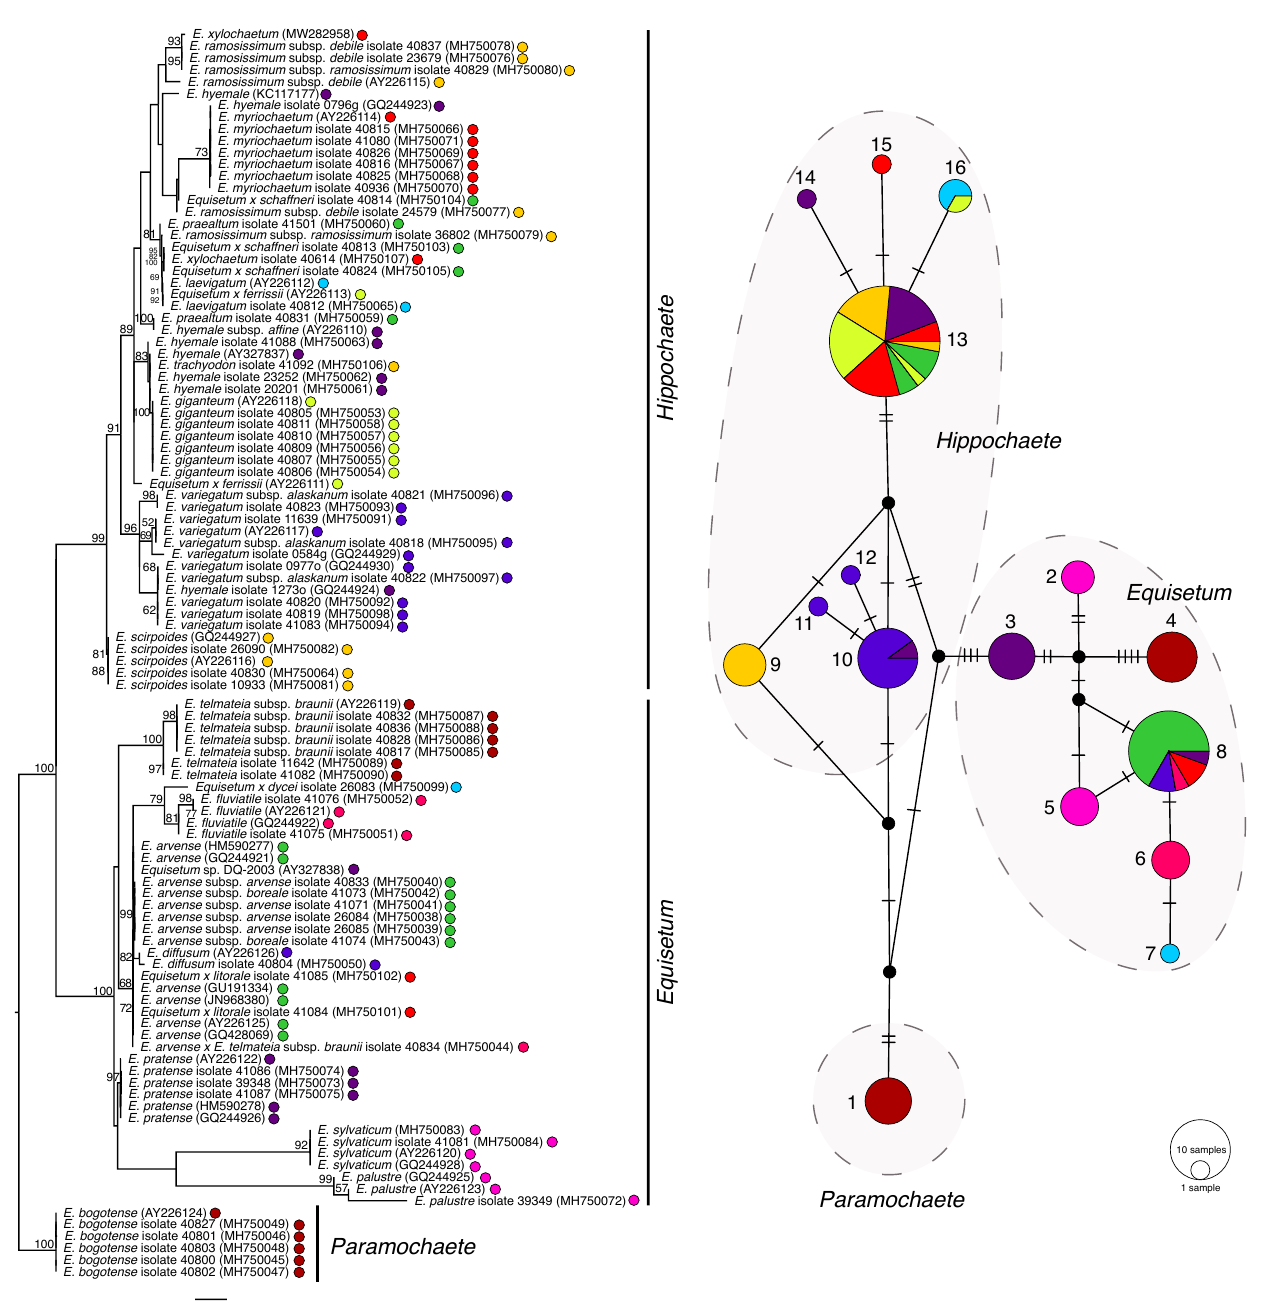
Figure 7. Phylogenetic estimation and TCS network of Equisetum trnL-trnF . The scale bar of the tree represents the estimated number of nucleotide substitutions per site. The maximum-likelihood boot- strap values are reported at the respective nodes. The colours of taxa present in the tree correspond with the colours in the TCS haplotype map. The size of the circle represents the number of the taxa that share the same